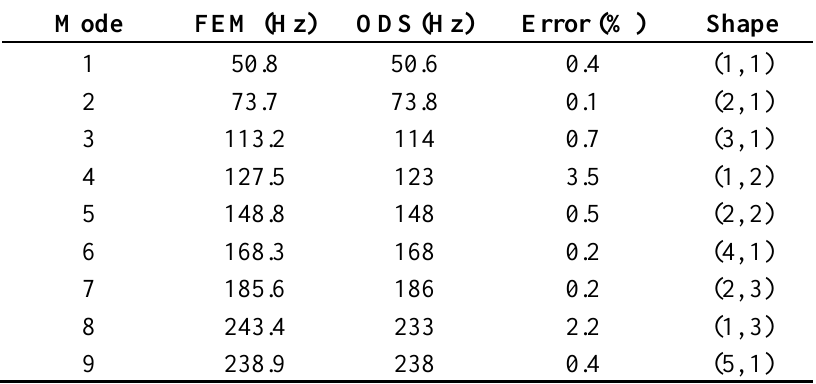
Table 4. Naked Metal Sheet FEM vs. ODS Frequencies.